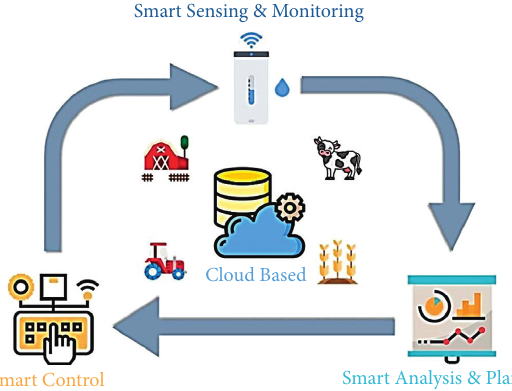
Figure 2: Smart farming